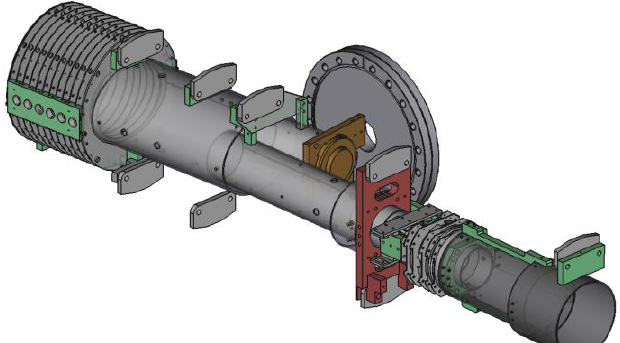
Fig. 1. Perspective view of the two-sided